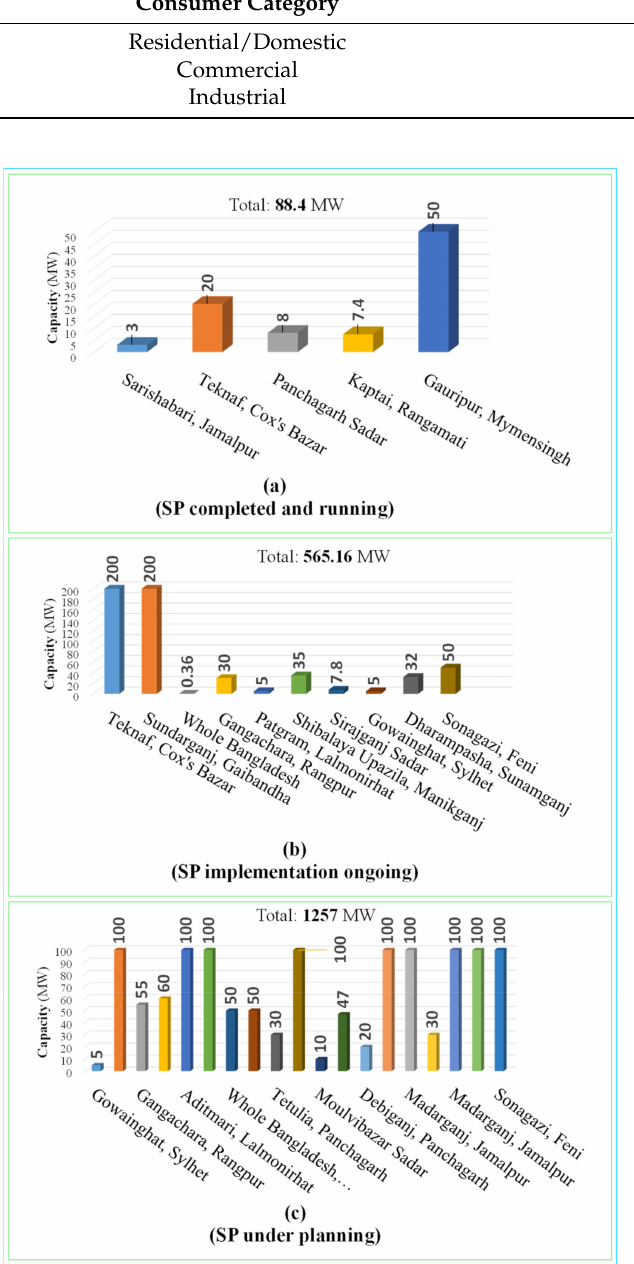
Figure 12. Present status of solar parks (SP): ( a ) SP completed and running, ( b ) SP implementation ongoing, and ( c ) SP under planning (authors’ creation based on SREDA data